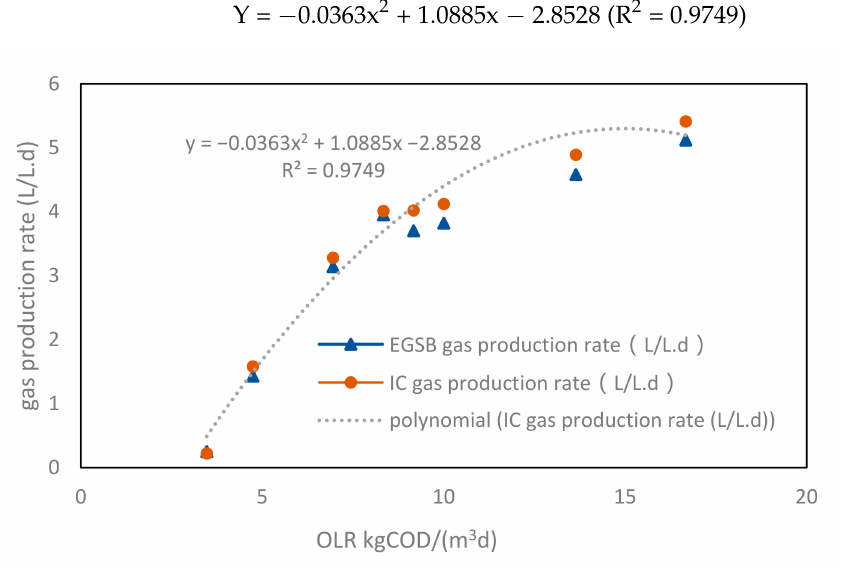
Figure 10. Second-order polynomial regression analysis of gas production rate and volume